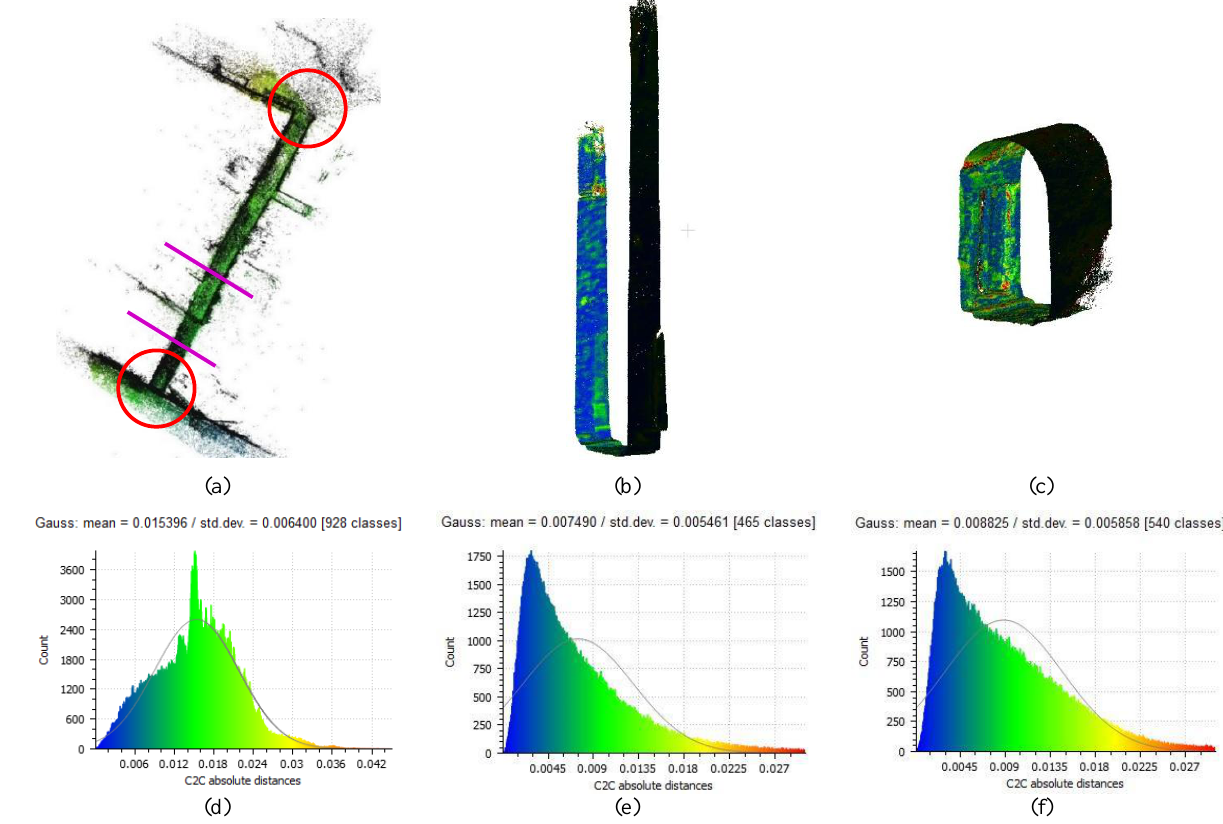
Figure 3: Test performed regarding the minimum number of points as well as their distribution. The result of the comparison of the sparse point cloud of the area generated using GCPs all over the area with the one created using GCPs only in the crossroads and the two cross-sections (in purple) (a) and the respective histogram (d), In (b) and (c) typical sections of the cloud of 1.00m width are presented along with their respective histograms (e) and